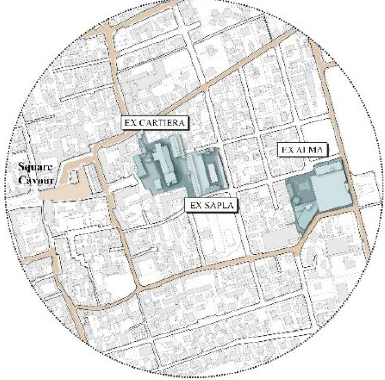
Figure 3. Location of the intervention areas within the local context of Bareggio